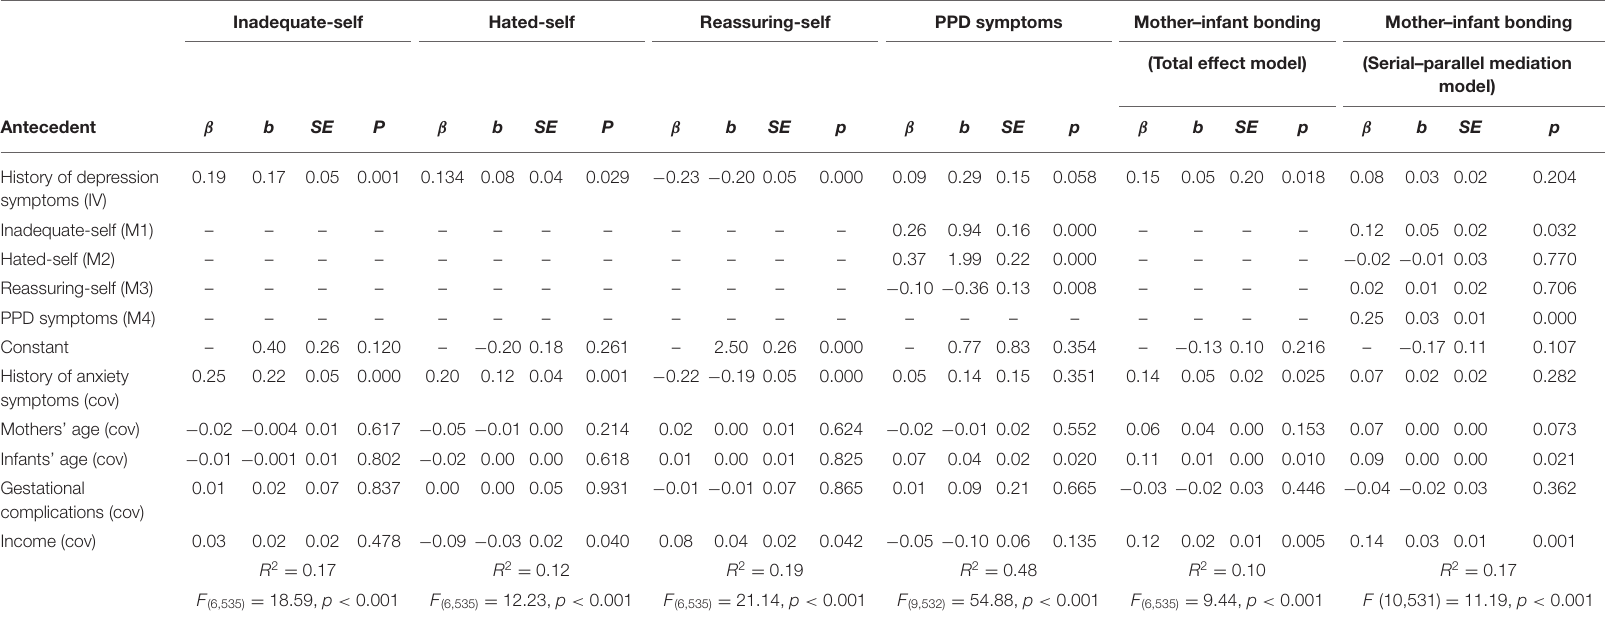
TABLE 3 | Standardized regression coefficients ( β ), unstandardized regression coefficients (b), standard errors (SE), and model summary information for the tested serial–parallel mediation Model